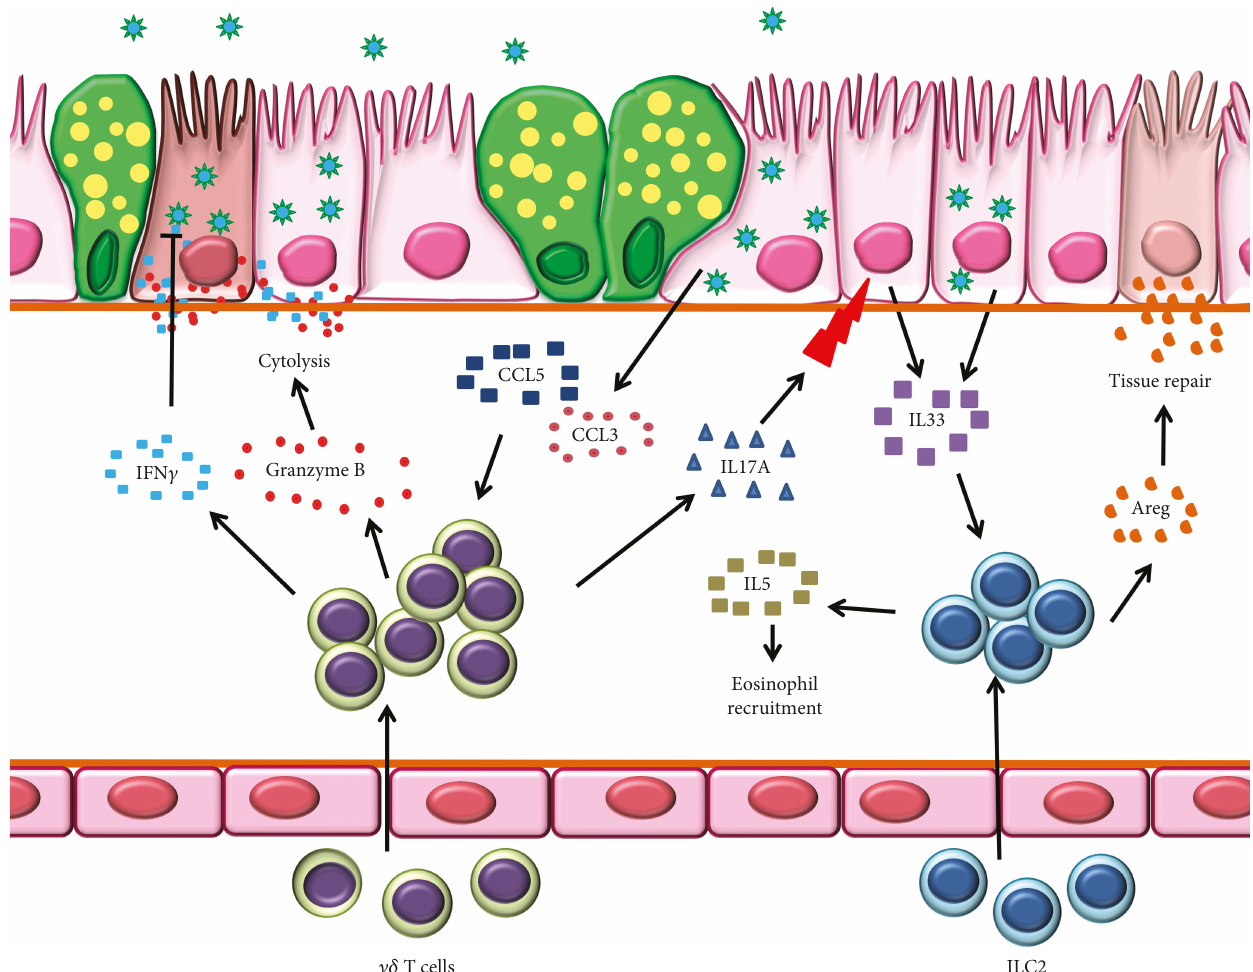
Figure 4: Innate lymphoid cells (ILCs) and γδ T cells are important during early stages of in fl uenza virus infection. Schematic representation of immunoprotection and immunopathology mediated by ILCs in the IAV-infected lungs. γδ T cell migration into the infected lungs is driven along the CCR5-CCL5 axis. γδ T cells destroy infected cells through the secretion of IFN γ and perforin-granzyme B pathway and secrete IL- 17A to trigger airway epithelium release of IL-33, a chemoattractant for ILC2. In addition, IL-33 secreted by IAV-infected epithelium enhances the tra ffi cking of ILC2 into the lungs. Activated ILC2s release amphiregulin (Areg) which helps to repair tissue damage and IL-5 which induces eosinophil tra ffi